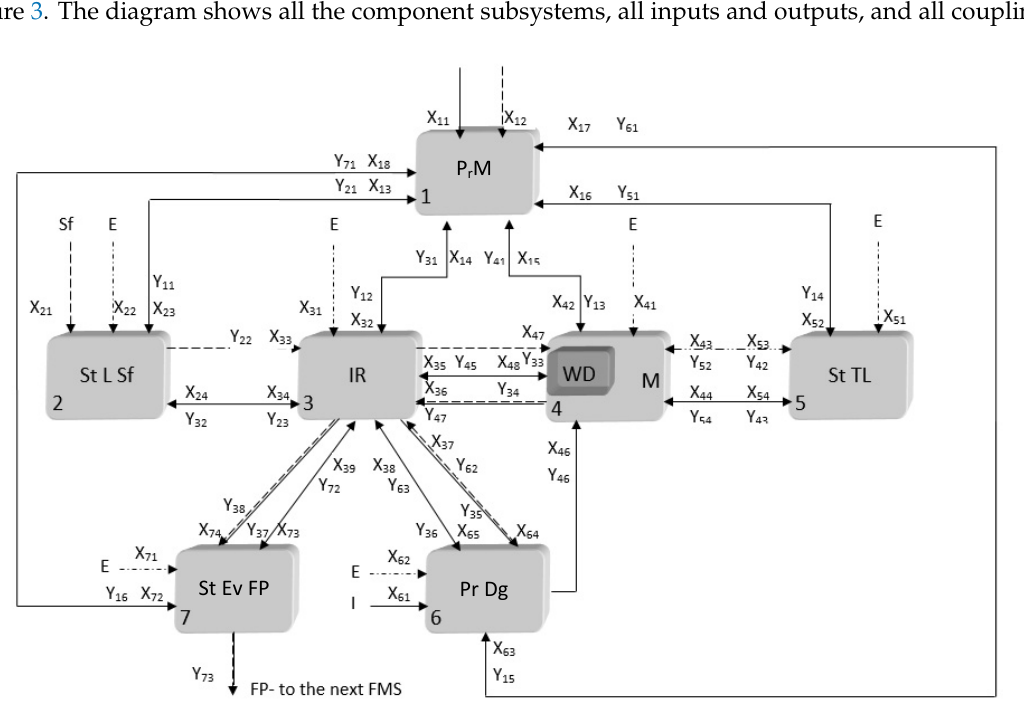
Figure 3. The decomposable structural diagram of the designed system.